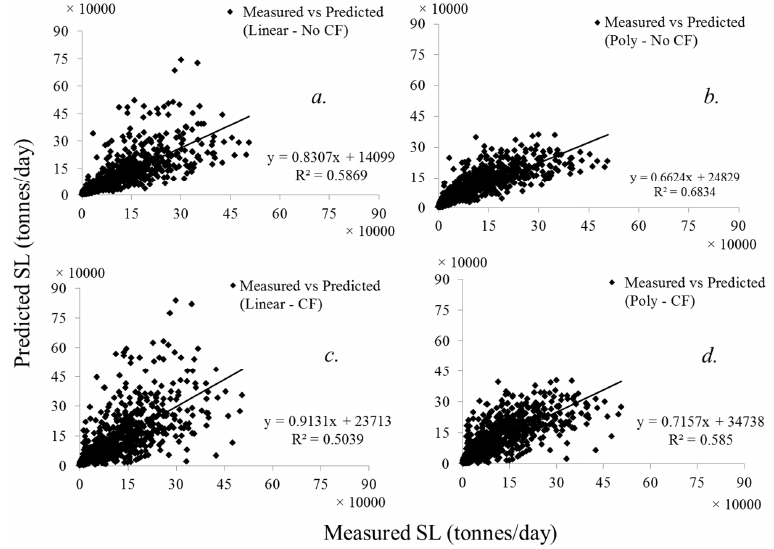
Figure 3. Scatter plots showing comparison between sand loads calculated from sand concentrations measured, processed and calibrated by USGS (Measured SL) and those predicted from several sand- rating curves (Predicted SL) at Tarbert Landing from 1973 to 2013. Specific terminologies pertaining to parts ( a ), ( b ), ( c ) and ( d ) of this figure i.e. , Linear, Poly, CF, and No CF are same as explained in Figure 2. It is noted that both predicted and measured SLs during the period 1986–1990 were eliminated in this comparison because of the low R 2 value of both rating curves during this period (please see Table